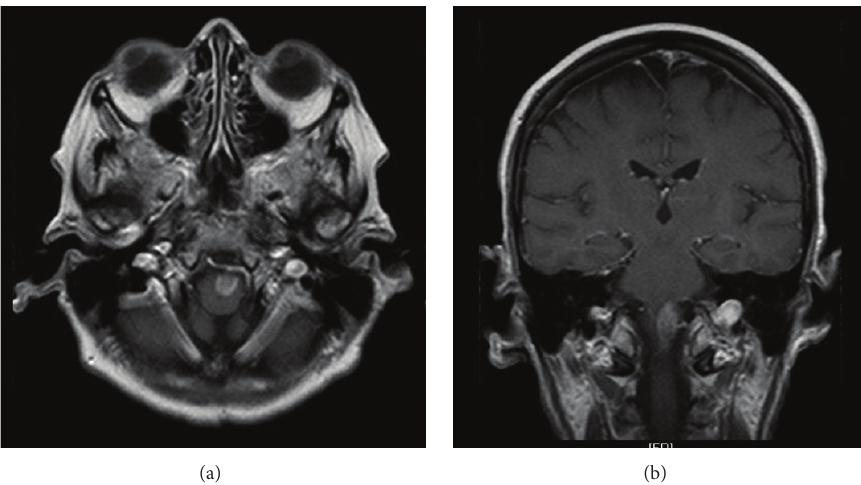
Figure 1: Initial brain MRI. (a) Axial T1-weighted image with gadolinium, showing the enhancing left medullary lesion. (b) Coronal T1- weighted image with gadolinium showing the same medullary lesion.